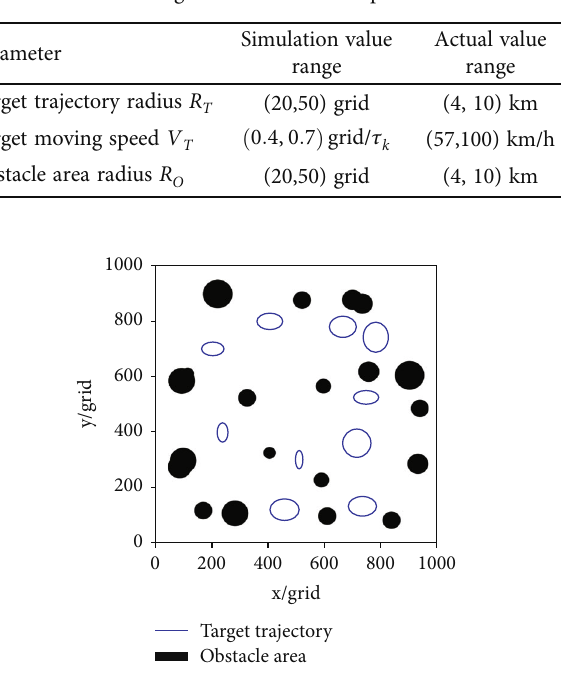
Table 2: Target and obstacle area parameters.